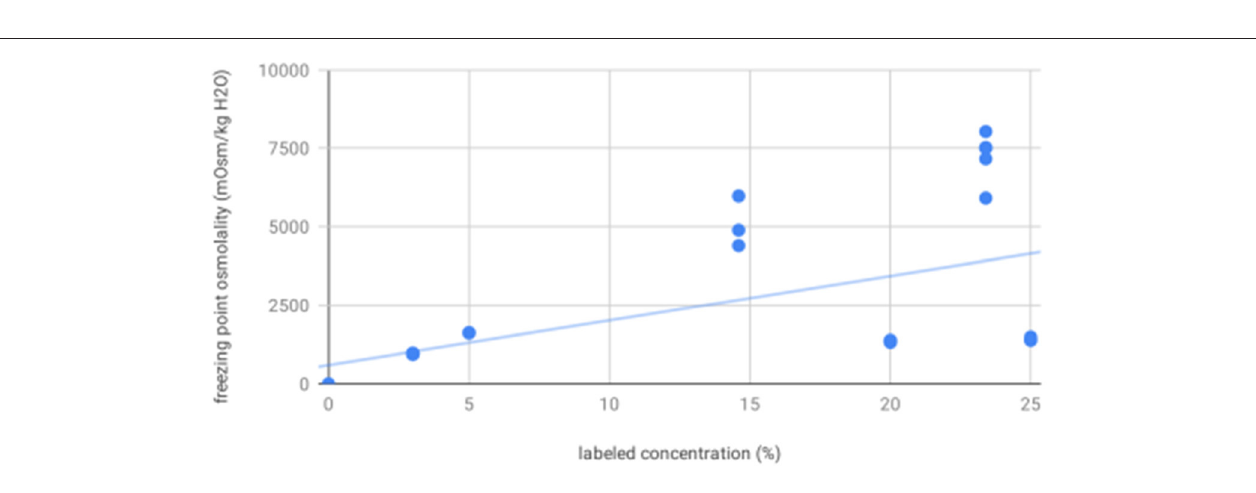
water (0.00). As expected, salinity/specific gravity as